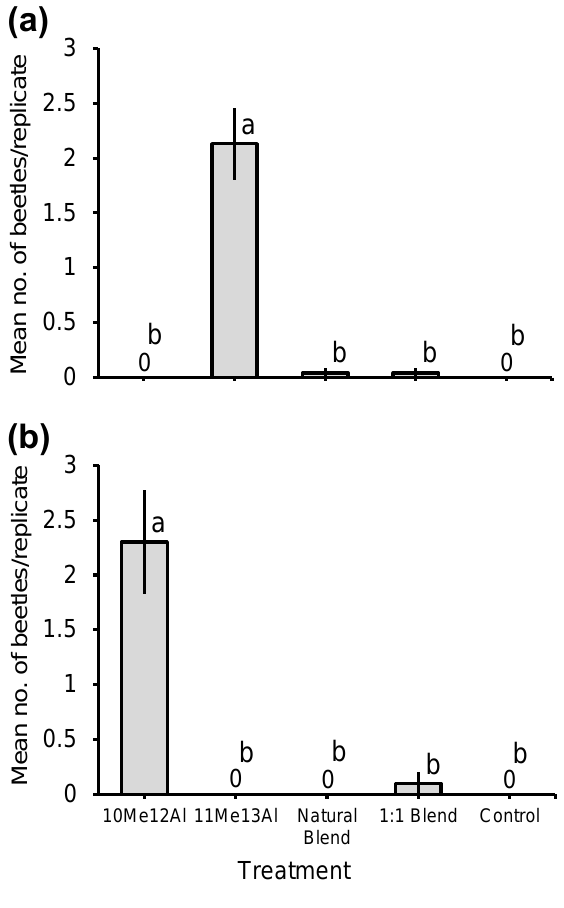
Figure 5. Mean ( ± 1 SE) numbers of adult males and females of ( a ) Eburodacrys dubitata and ( b ) Eburodacrys vittata caught during bioassays testing the synthetic pheromone candidates as attractants for Eburodacrys assimilis in Valentim Gentil in 2018. Treatments: 10Me12Al = racemic 10-methyldodecanal; 11Me13Al = racemic 11-methyltridecanal; Natural blend = 36:100 blend of racemic 10-methyldodecanal and 11-methyltridecanal (ratio produced by adult males of E. assimilis ); 1:1 Blend = 1:1 blend of the two aldehydes; and Control = neat isopropanol. Means related to the same species capped by different letters are significantly different (REGWQ multiple range test: p ≤ 0.05).